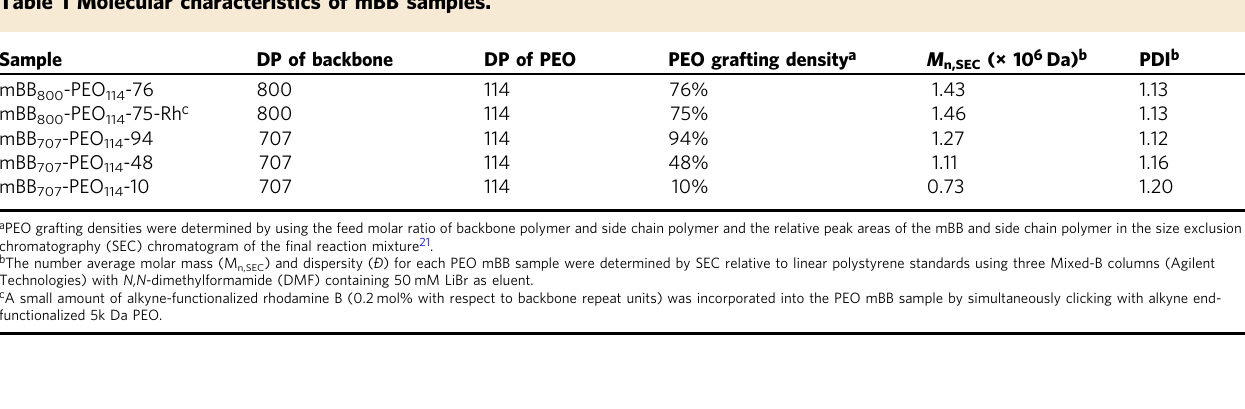
Fig. 1 Single crystals of linear PEO and mBBs. ( a ) Schematic illustration, TEM image and SAED pattern of a PEO PSC. ( b ) Chemical structure and schematic of an mBB. c TEM image with an SAED pattern, ( d ) AFM and ( e – h ) SEM images of mBB PSCs crystallized at 20 °C for 2 h ( c – e ), 10 min ( f ), 20 min ( g ) and 30 min ( h ). ( i ) Temporal evolution of mBBC. Blue dots: diameter; Red square: shell cap area; error bar represents standard deviation based on ten mBBCs. ( j ) mBB crystals from 0.02 wt.% mBB solution. ( k , l ) mBB crystals after adding the same mBB polymer ( k ) and 5k Da linear PEO ( l ) to pre- formed crystalline shells. Scale bars: 2 μ m. Table 1 Molecular characteristics of mBB